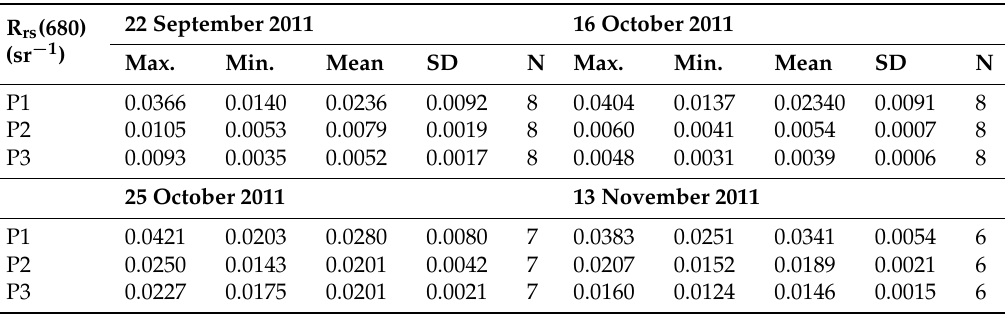
Figure 12. Remote sensing reflectance (R rs ( λ )) at different GOCI bands at Stations P1, P2 and P3 derived from GOCI images on 22 September (N = 8), 16 October (N = 8), 25 October (N = 7) and 13 November 2011 (N = 6). Different colors represent different stations. Note that the magnitude of diurnal variation of R rs at Station P1 was larger than they were at Station P2 and P3 for all four days. Table 6. R rs (680) derived from GOCI images on 22 September, 16 October, 25 October and 13 November 2011. “Max.”, “Min.”, and “SD” stand for maximum, minimum, and standard deviation, respectively, and “N” is the number of